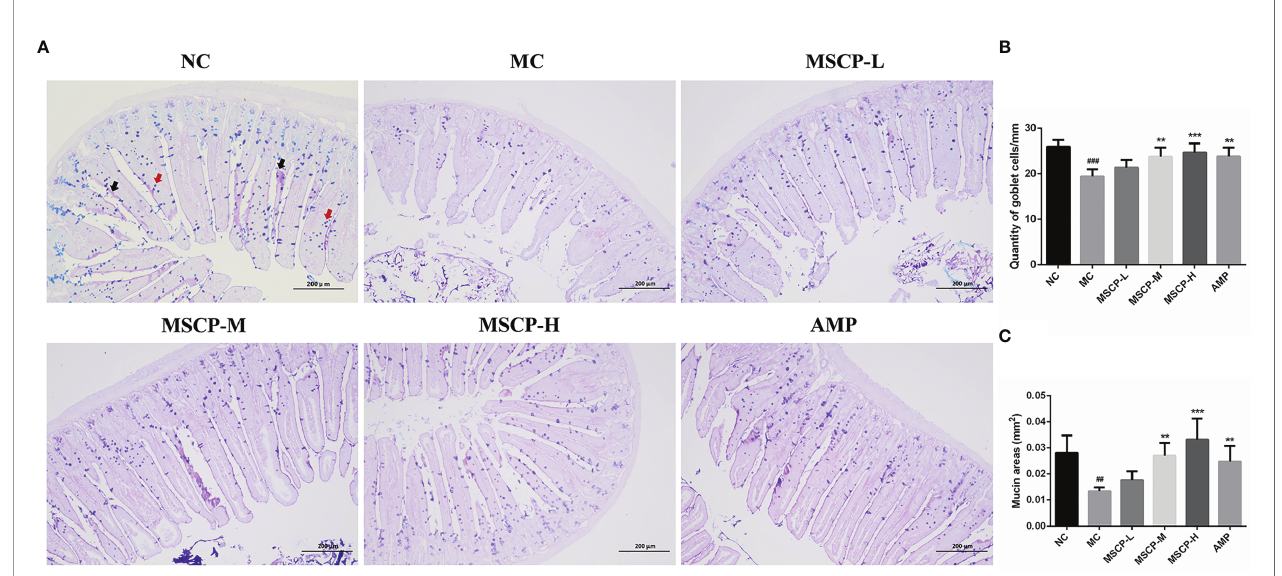
FIGURE 8 | The goblet cells and mucins area were observed by AB-PAS staining in the jejunum. (A) AB-PAS staining of jejunum section (100 ×, Scale bar = 200 mm). Red arrow represents the goblet cells and black arrow represents the mucins. (B) The quantity of goblet cells/mm. (C) Mucin areas (mm 2 ). Data are expressed as mean ± SD. ## p < 0.01, ### p < 0.001 compared with NC group; ** p < 0.01, *** p < 0.001 compared with MC